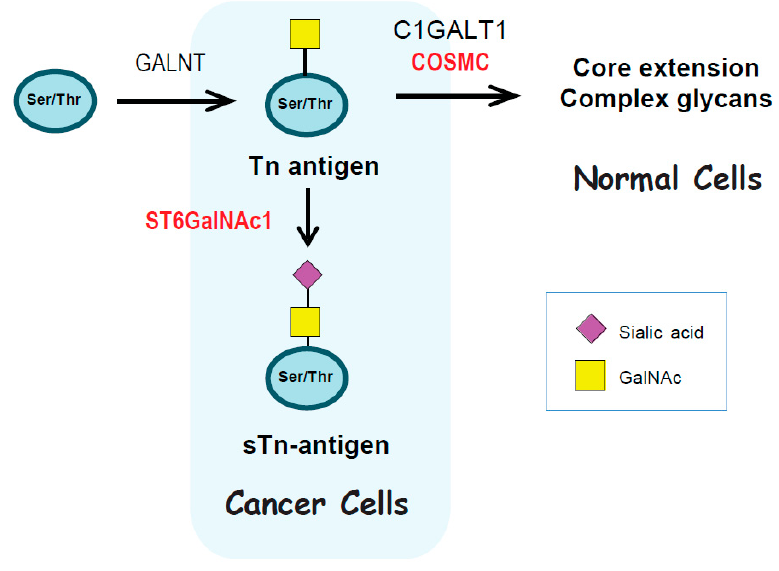
Figure 1. Biosynthesis of the Sialyl-Tn (sTn) antigen in cancer cells.